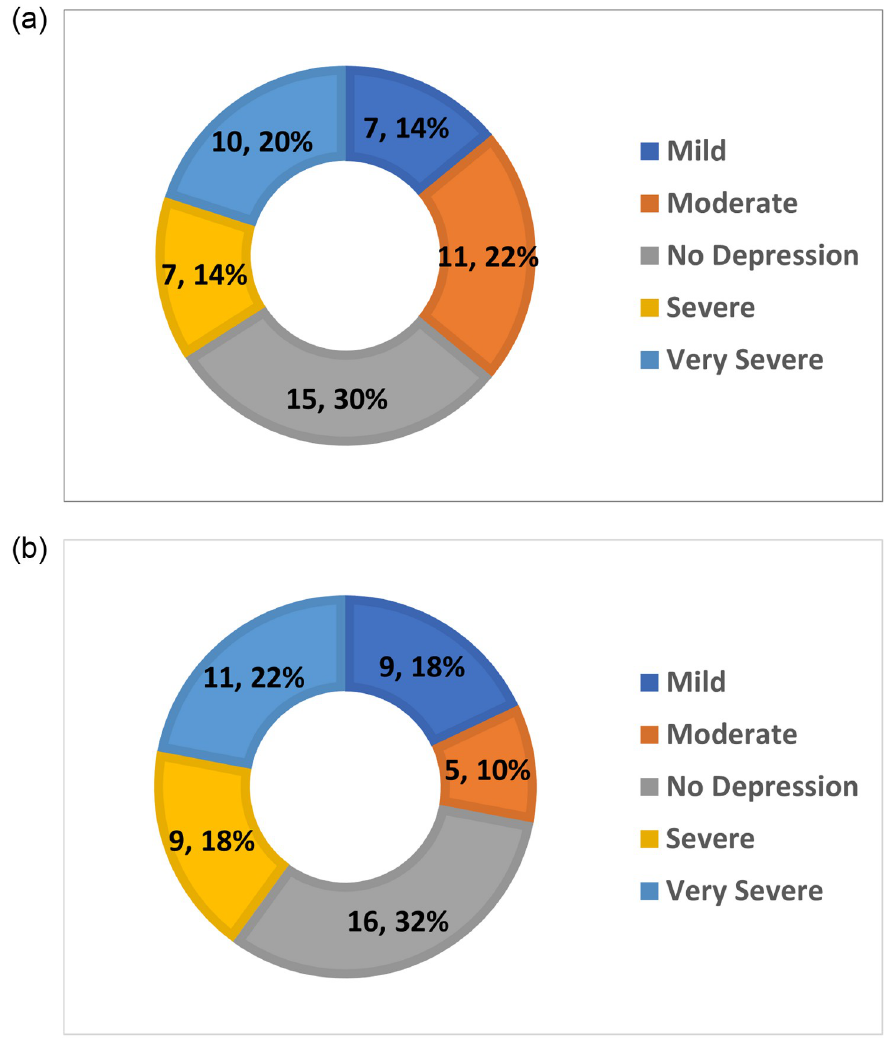
Fig 7. Depression level statistics based on scoring systems (IDS-SR and QIDS-SR). ( a ) IDS-SR. ( b ) QIDS-SR.